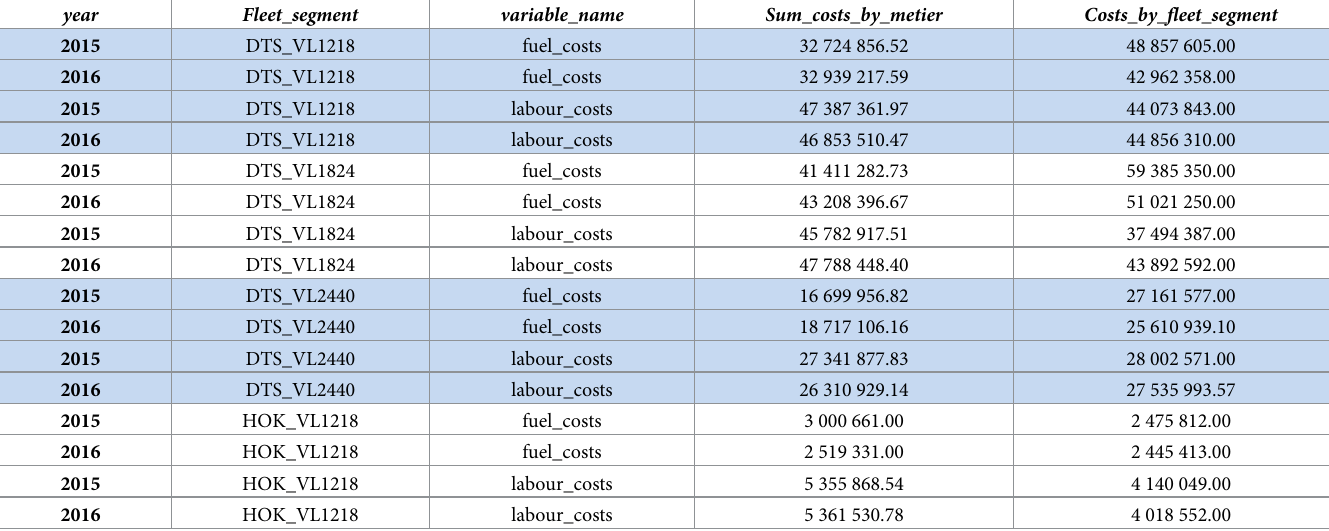
Table 4. Results of the consistency checks between variable costs by fleet segment and variable costs disaggregated by me´tier.